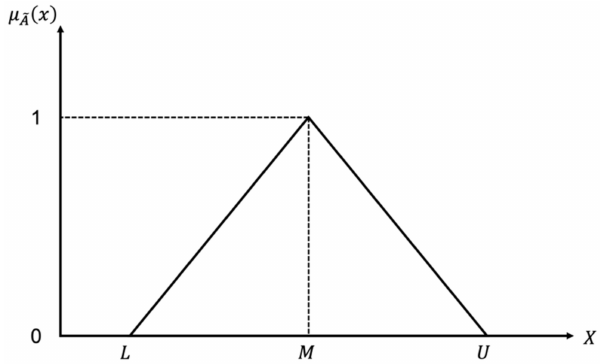
Figure 4. Fuzzy triangular